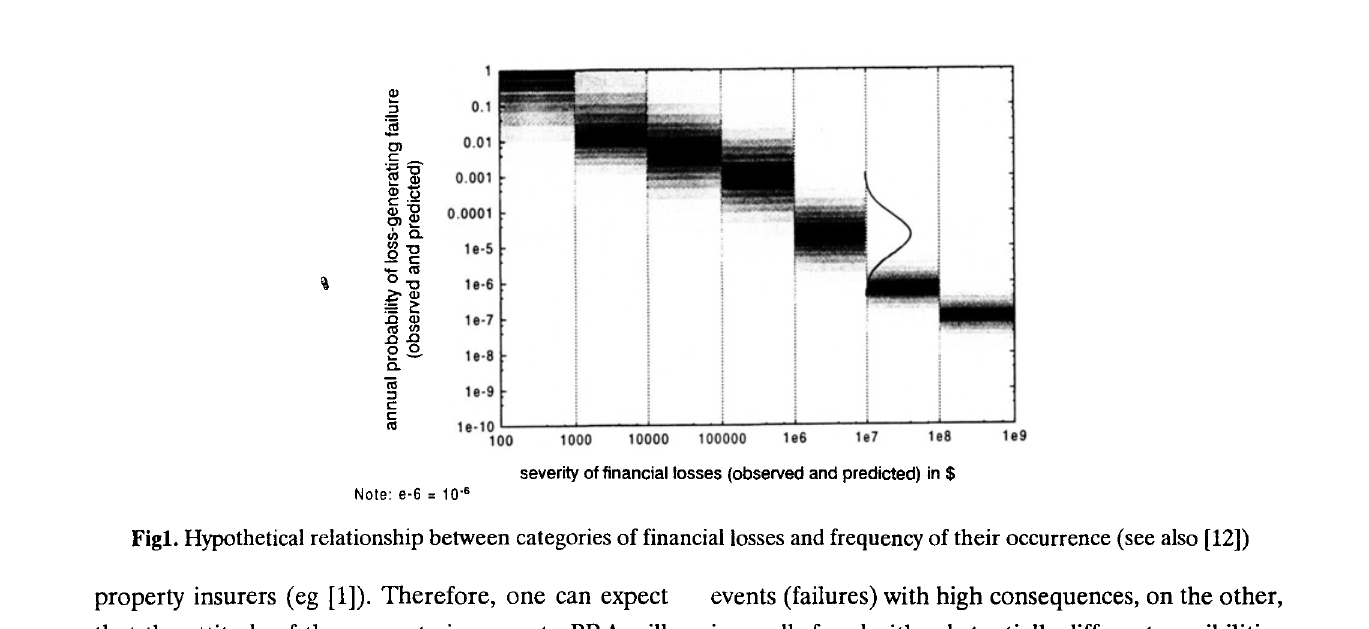
Figl. Hypothetical relationship between categories of financial losses and frequency of their occurrence (see also [12]) property insurers ( eg [1 ]). Therefore, one can expect be